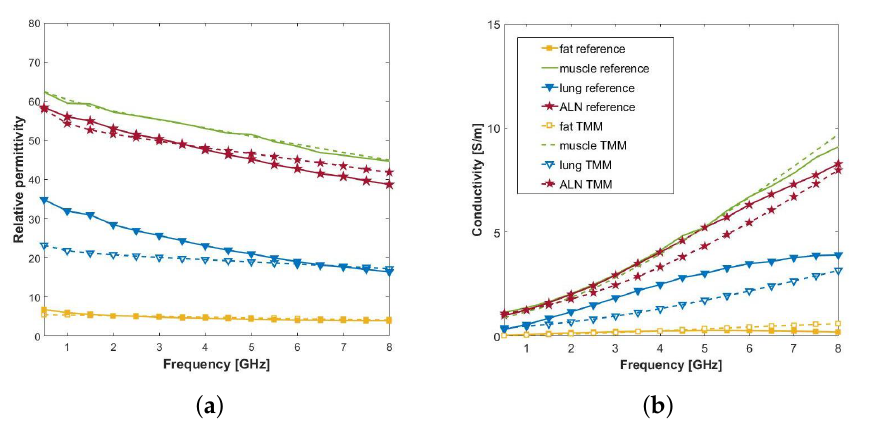
Figure 5. Solid lines : reference permittivity of the four tissues of interest: fat, muscle, lung, and axillary lymph nodes (ALN). Dashed lines: measured permittivity of the corresponding liquid tissue mimicking materials (TMMs). ( a ) Relative permittivity, (cid:101) (cid:48) , and ( b ) conductivity σ .